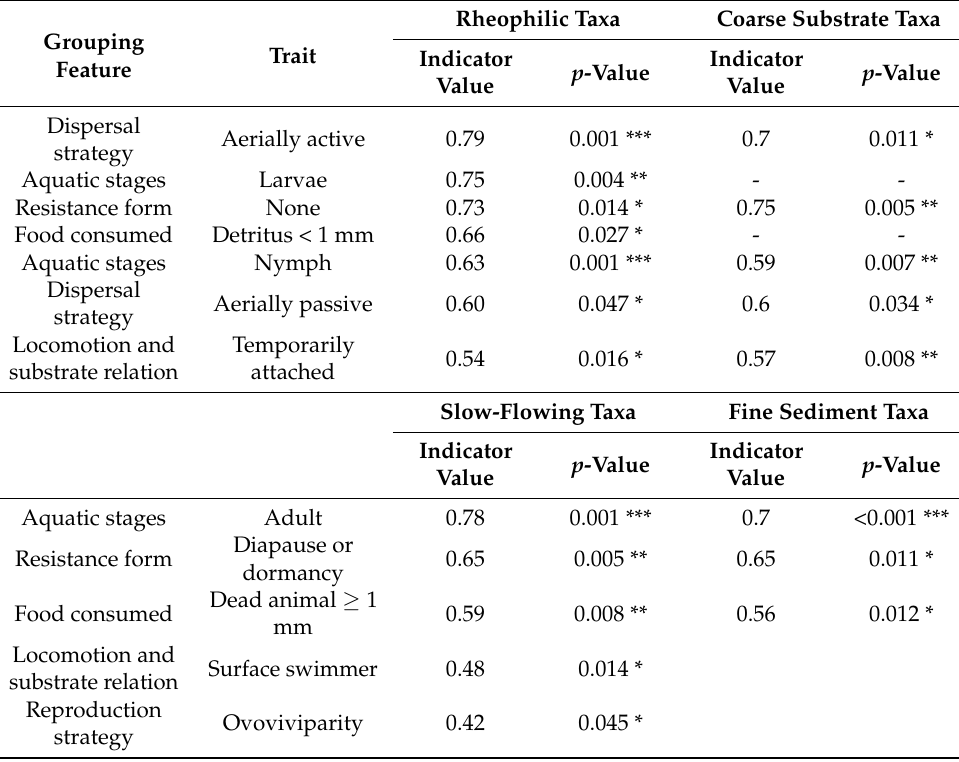
Table 6. Indicator species analysis quantifying the association of individual taxa and functional traits with taxa preferring specific flow velocities and substrate sizes. Stars denote the degree